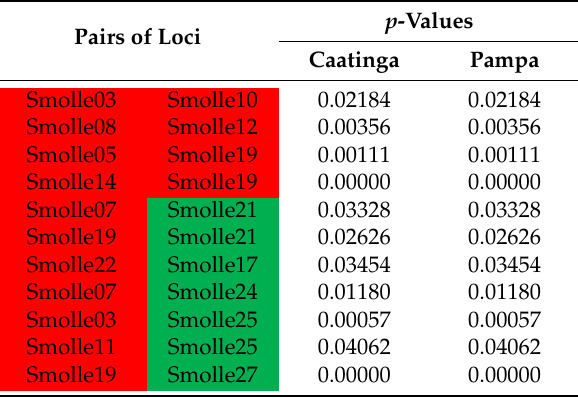
Table 4. Pairs of loci with statistically significant ( p < 0.05) estimations of linkage disequilibrium (LD) in both populations. Supplementary Table S2 presents the list of all pairs of loci with significant LD. ptSSR markers are highlighted in red and nSSR markers in green. p -Values Pairs of Loci Caatinga